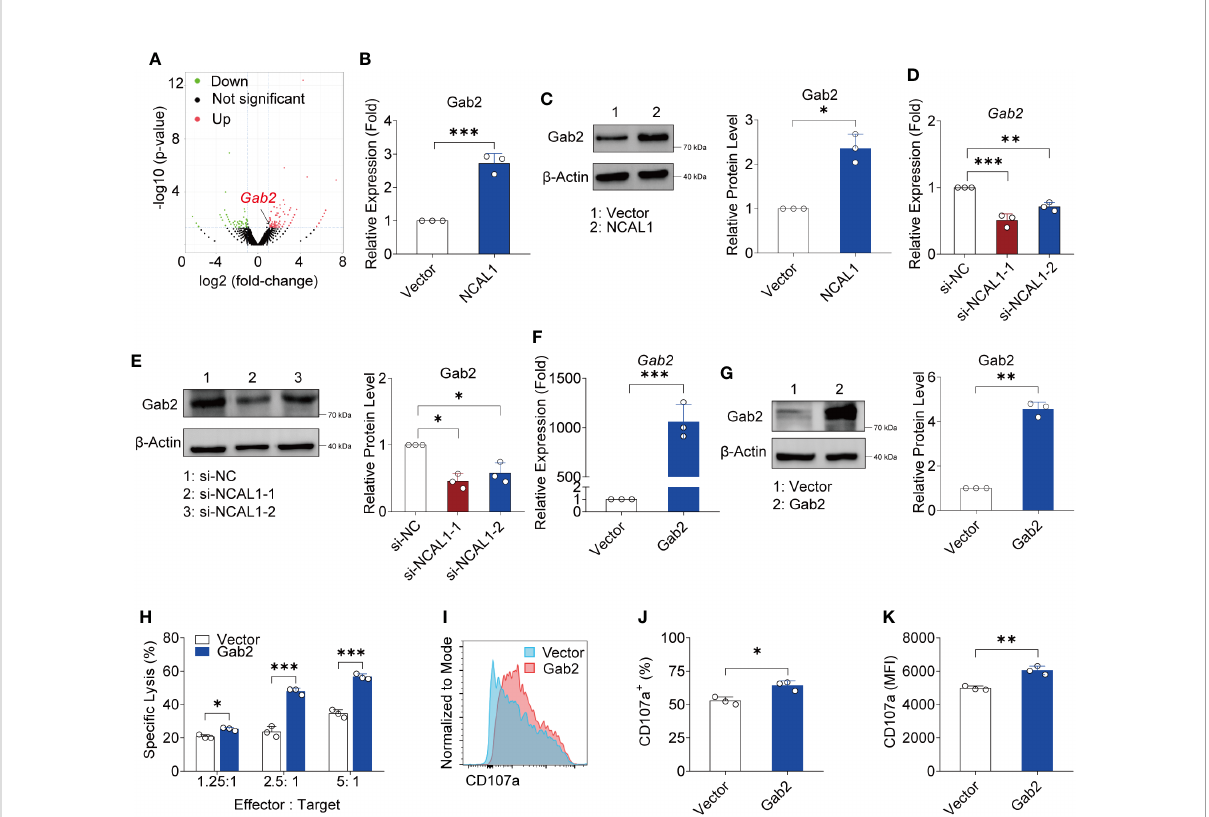
FIGURE 4 NCAL1 increases NK cell-mediated cytotoxicity by upregulating Gab2. (A) Volcano plot of differentially expressed genes between NCAL1- overexpressing NK92MI cells and control NK92MI cells. The red dots on the right indicate upregulated genes, and the green dots on the left indicate downregulated genes. (B) NCAL1 overexpression increases Gab2 gene expression. NK92MI cells were transfected with NCAL1- overexpressing lentivirus or control vector lentivirus for 48 h. After GFP-positive cell selection, stable cells were collected for qPCR to